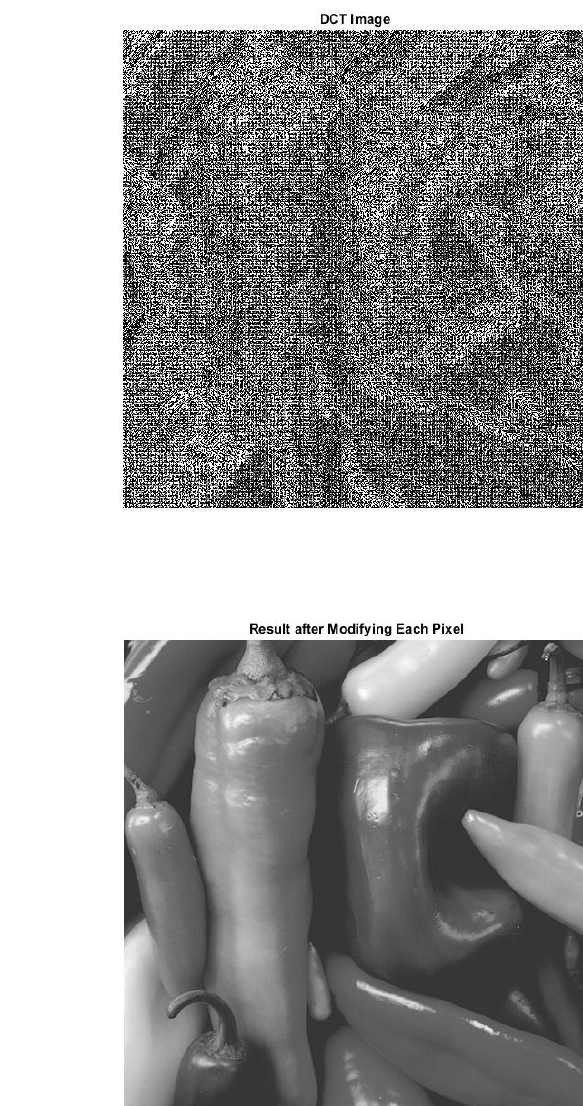
Table 2. Calculation of DC Coefficient.